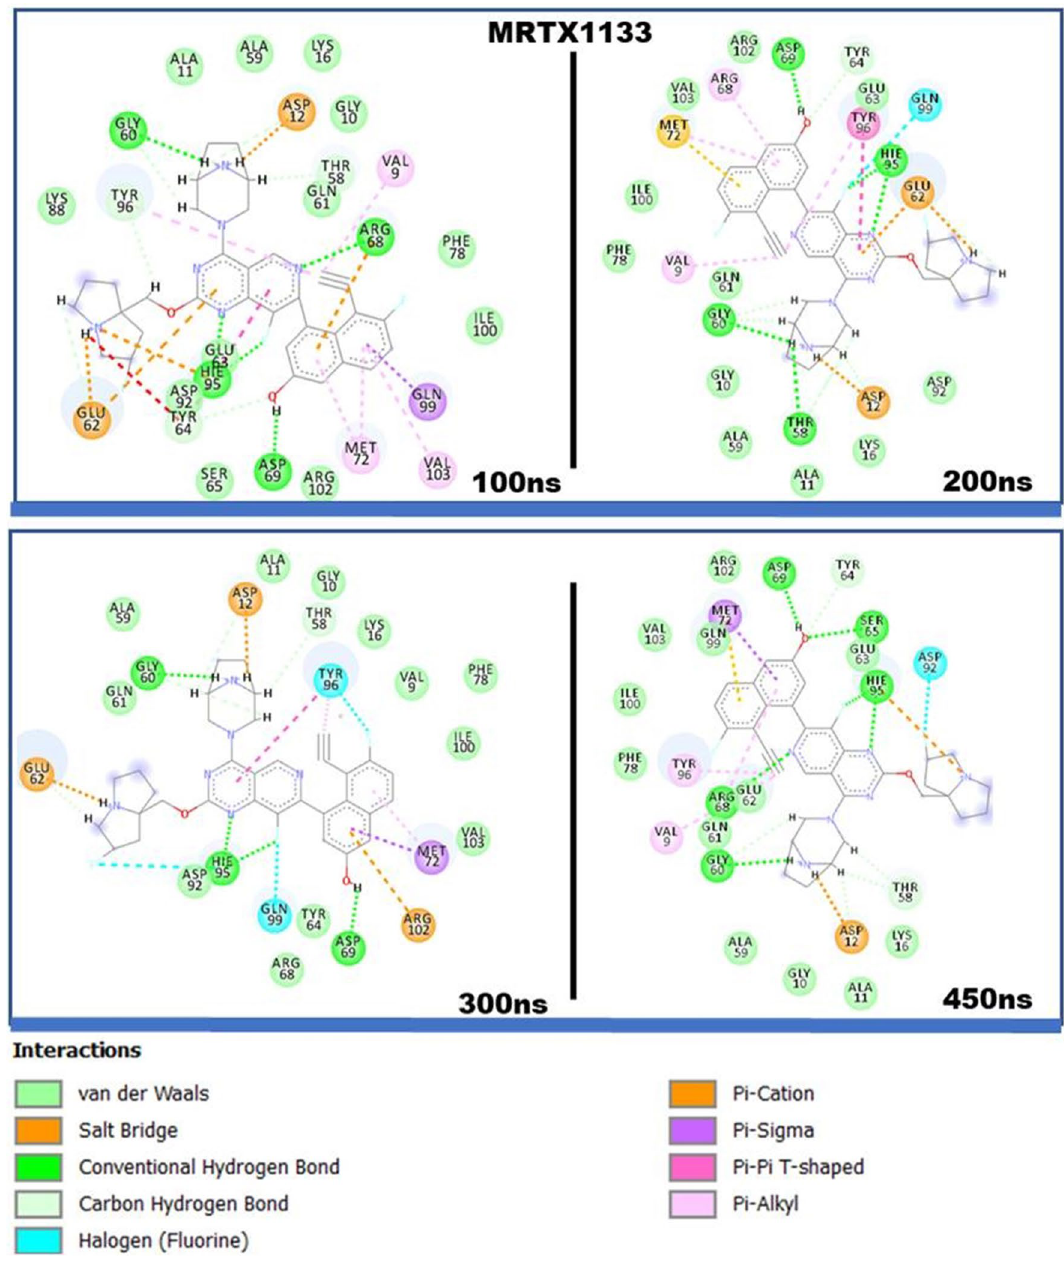
Figure 4. 2D interactions of MRTX1133 with KRAS G12D binding site residues. Snapshots depicts interactions at 100 ns, 200 ns, 300 ns and 450 ns. MRTX1133 engages in varying